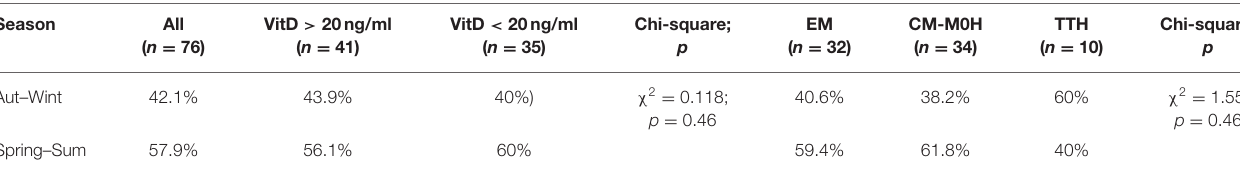
TABLE 4 | Seasons of enrolment in the whole sample divided by vitamin D levels and headache